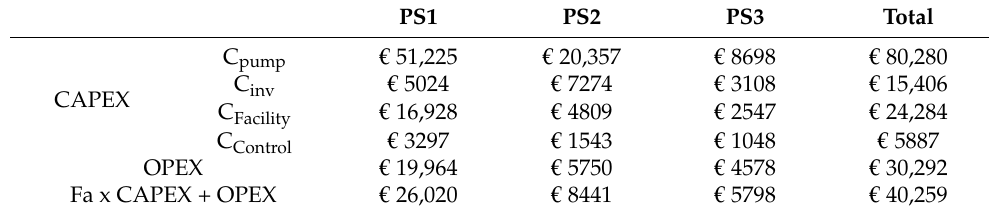
Table 7 details the CAPEX and OPEX values for the best solution found. First, on the dotted line, all CAPEX terms of Equation (9) are exposed. The OPEX costs are shown according to Equation (13). The last row details the annualized costs according to Equation (2) for each PS. In this case study, the calculated coefficient F a is 0.0791. The total annualized cost is highlighted in the lower right corner of the table. Table 7. Cost details of the obtained